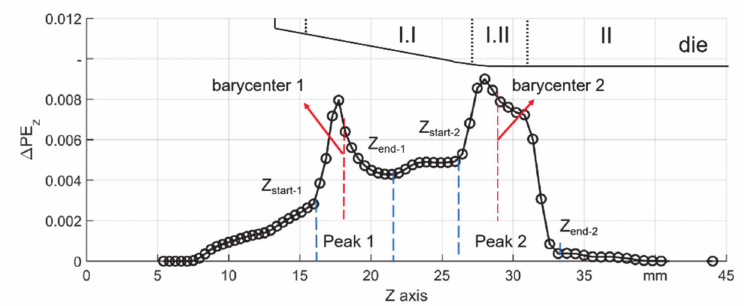
Figure 4. Description of the two local ∆ PE z peaks and the